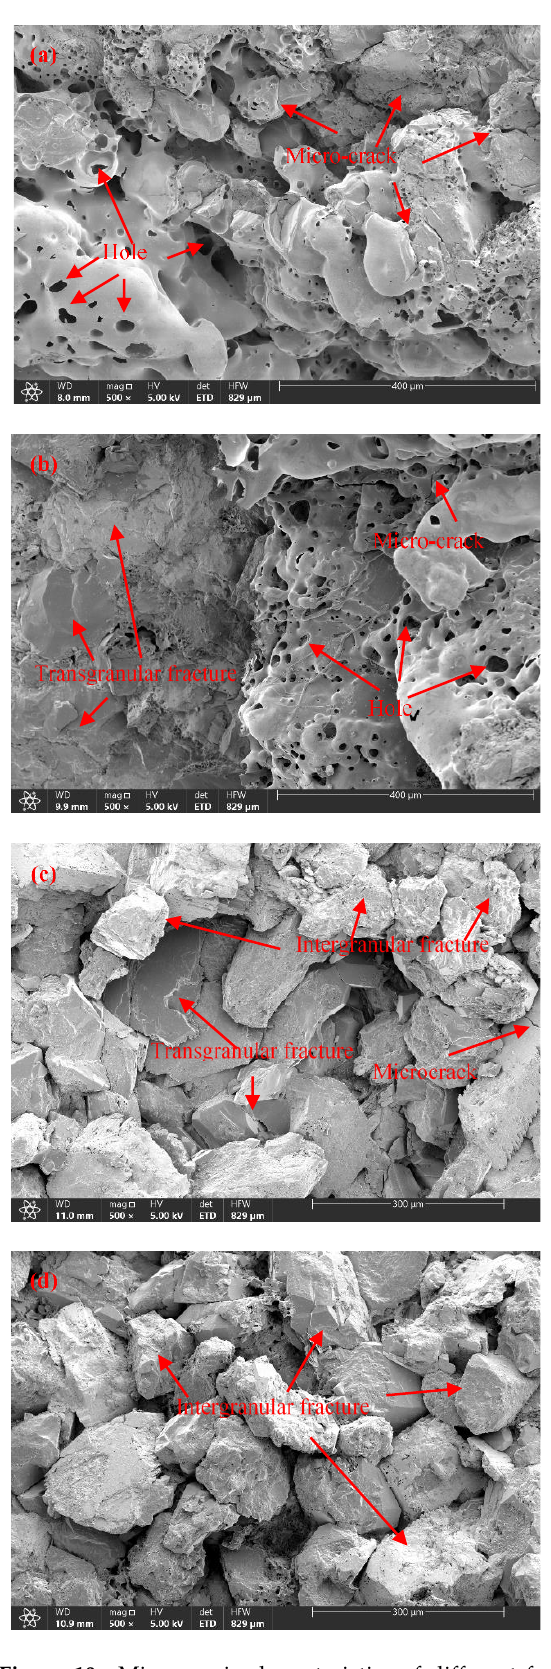
Figure 10. Microscopic characteristics of different fracture positions in sandstone after electric breakdown: ( a ) Point A; ( b ) Point B; ( c ) Point C; ( d ) Point D.